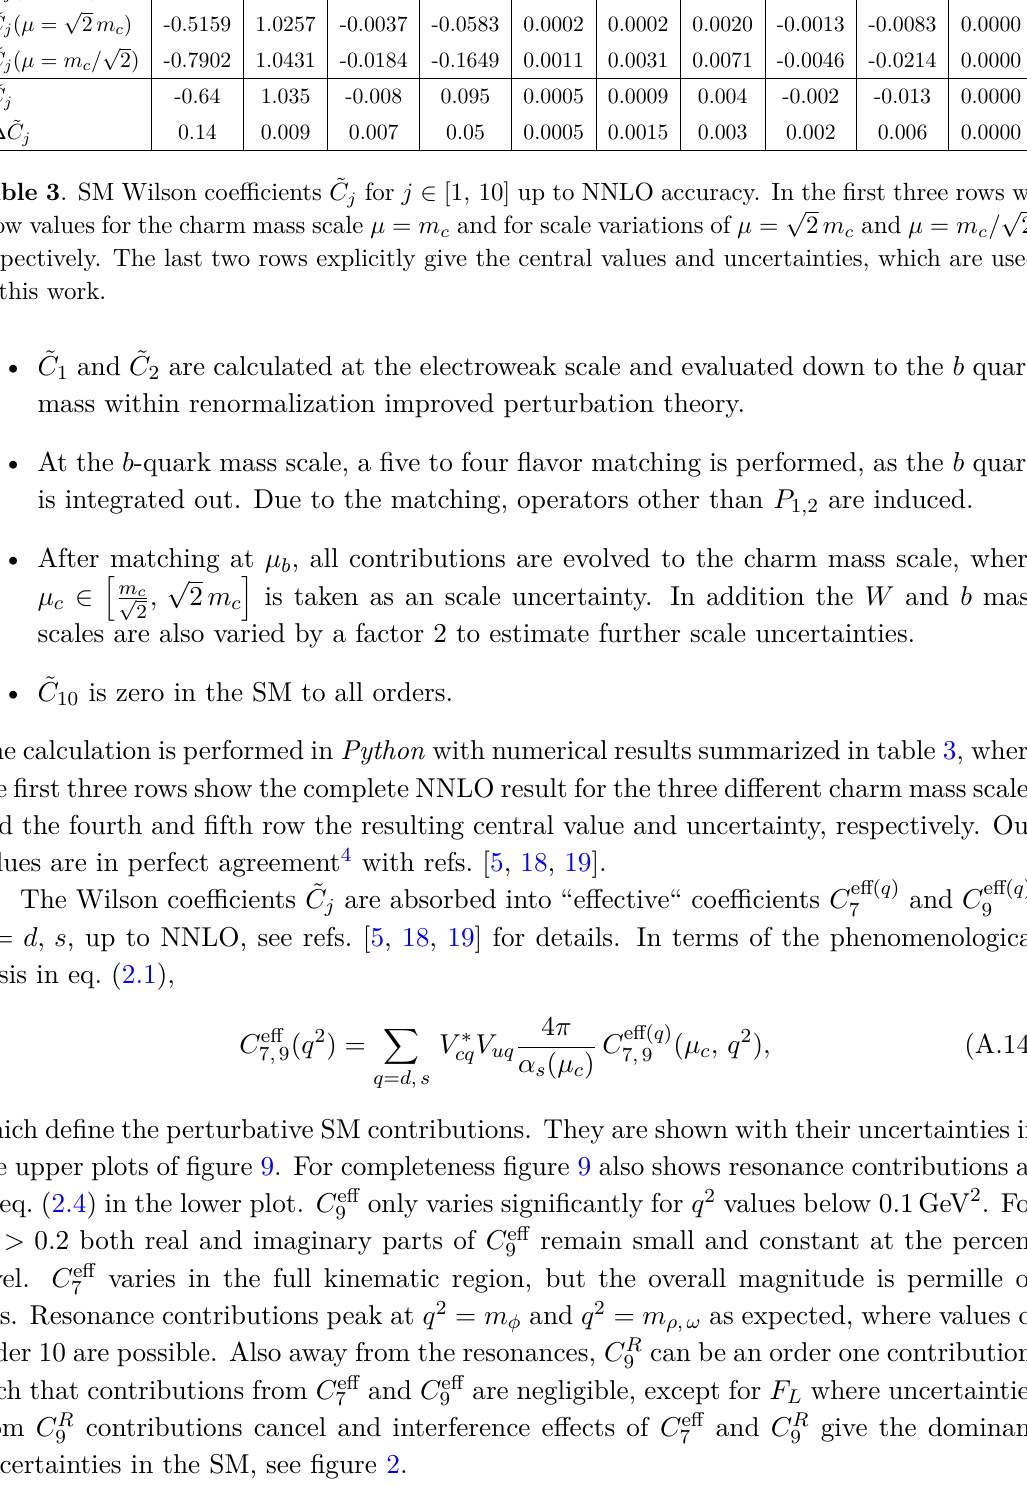
√ √ 2 m and µ = m 2 , c c /